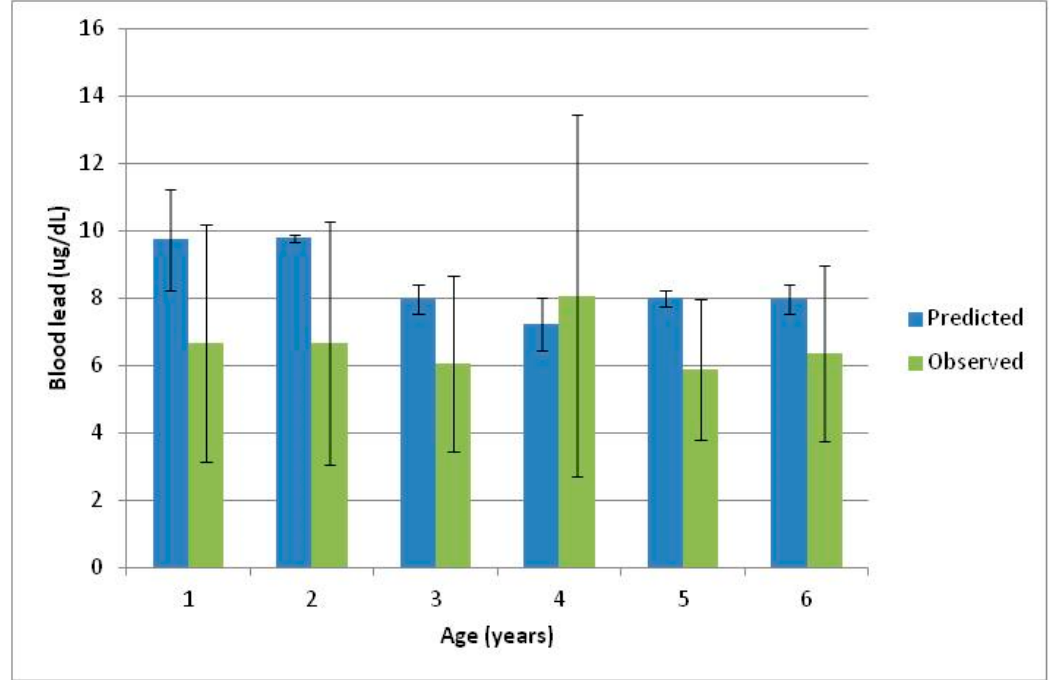
Figure 3. Comparison of the geometric means predicted and mean observed blood Pb against age (for 31% food Pb bioavailability and a default 30% soil Pb bioavailability).